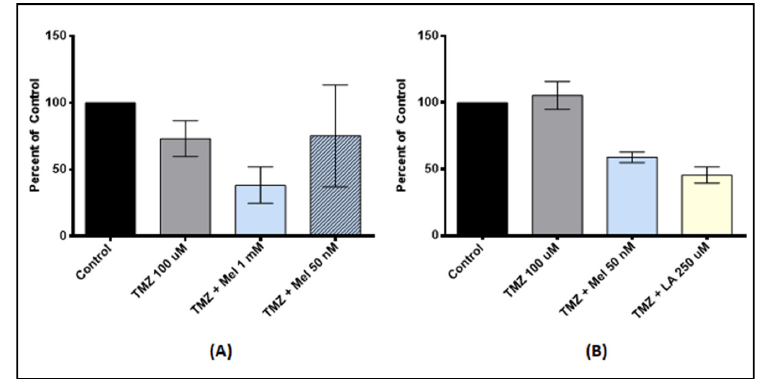
Figure 4. Cell proliferation of U87-MG stem-like cells ( A ) and MU1454 stem-like cells ( B ) measured via the MTT assay after serial 72 h treatments with antioxidants (Lipoic Acid [LA] or Melatonin [Mel]) followed by TMZ at 100 uM. Dose of TMZ is constant at 100 uM, while dose of antioxidant varies and is indicated on the graph. ( A ) scU87 cells after pre-treatment with melatonin at 1 mM and 50 nM followed by TMZ. ( B ) scMU1454 cells after pre-treatment with melatonin at 50 nM and Lipoic acid at 250 uM followed by TMZ. Error bars represent the 95% confidence interval.